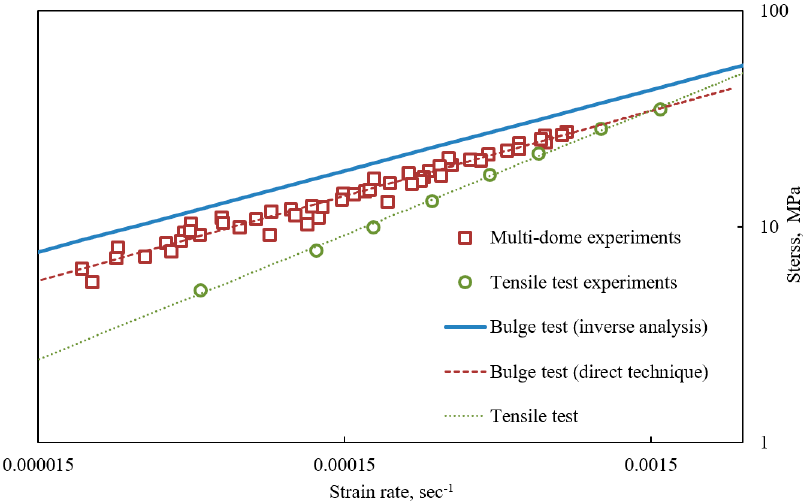
Figure 4. Results of multi-dome forming tests, tensile tests, and constitutive equations obtained by their processing, plotted in logarithmic scale.